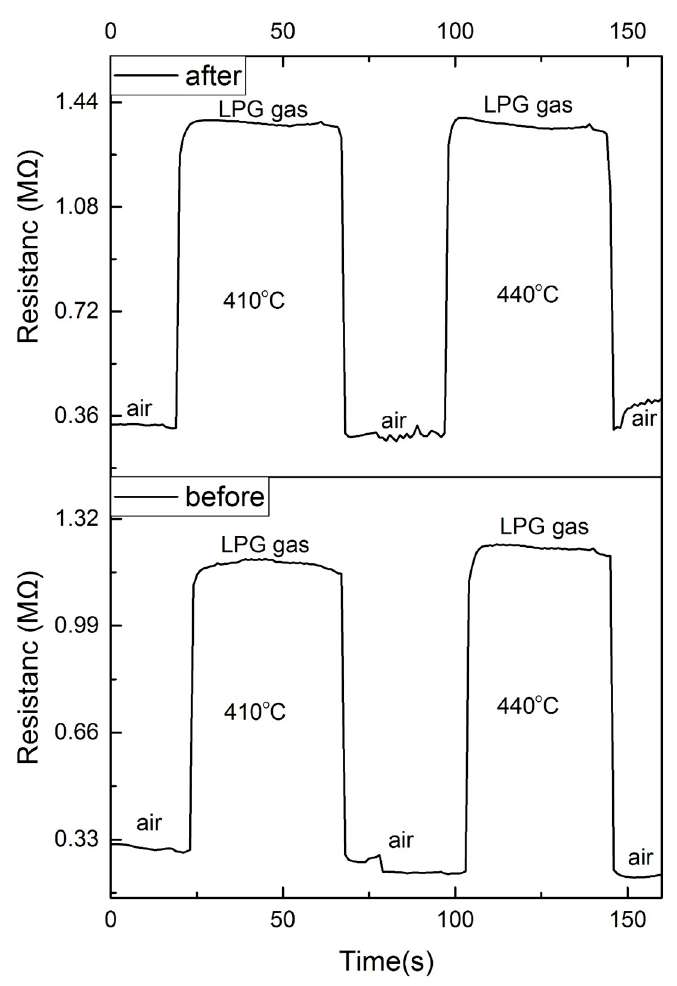
Figure 6. The response and recovery behavior of TTO2 to 10,000 ppm LPG before and after one week.